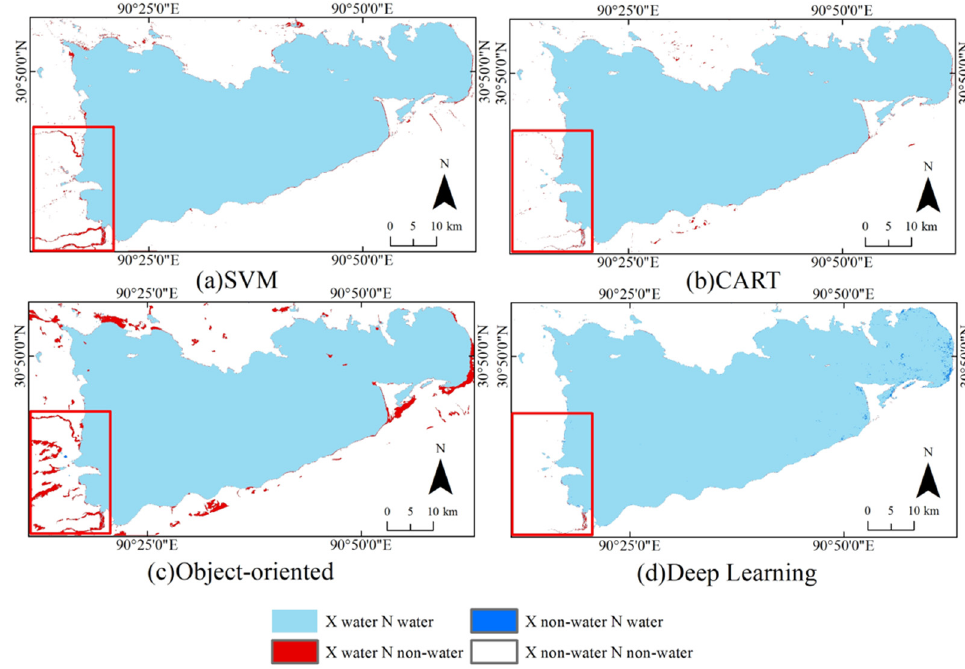
Figure 5. Superimposed comparison of different methods and NDWI water extraction results in Nam Co ( a ) SVM; ( b ) CART; ( c ) Object-Oriented; ( d ) Deep Learning.